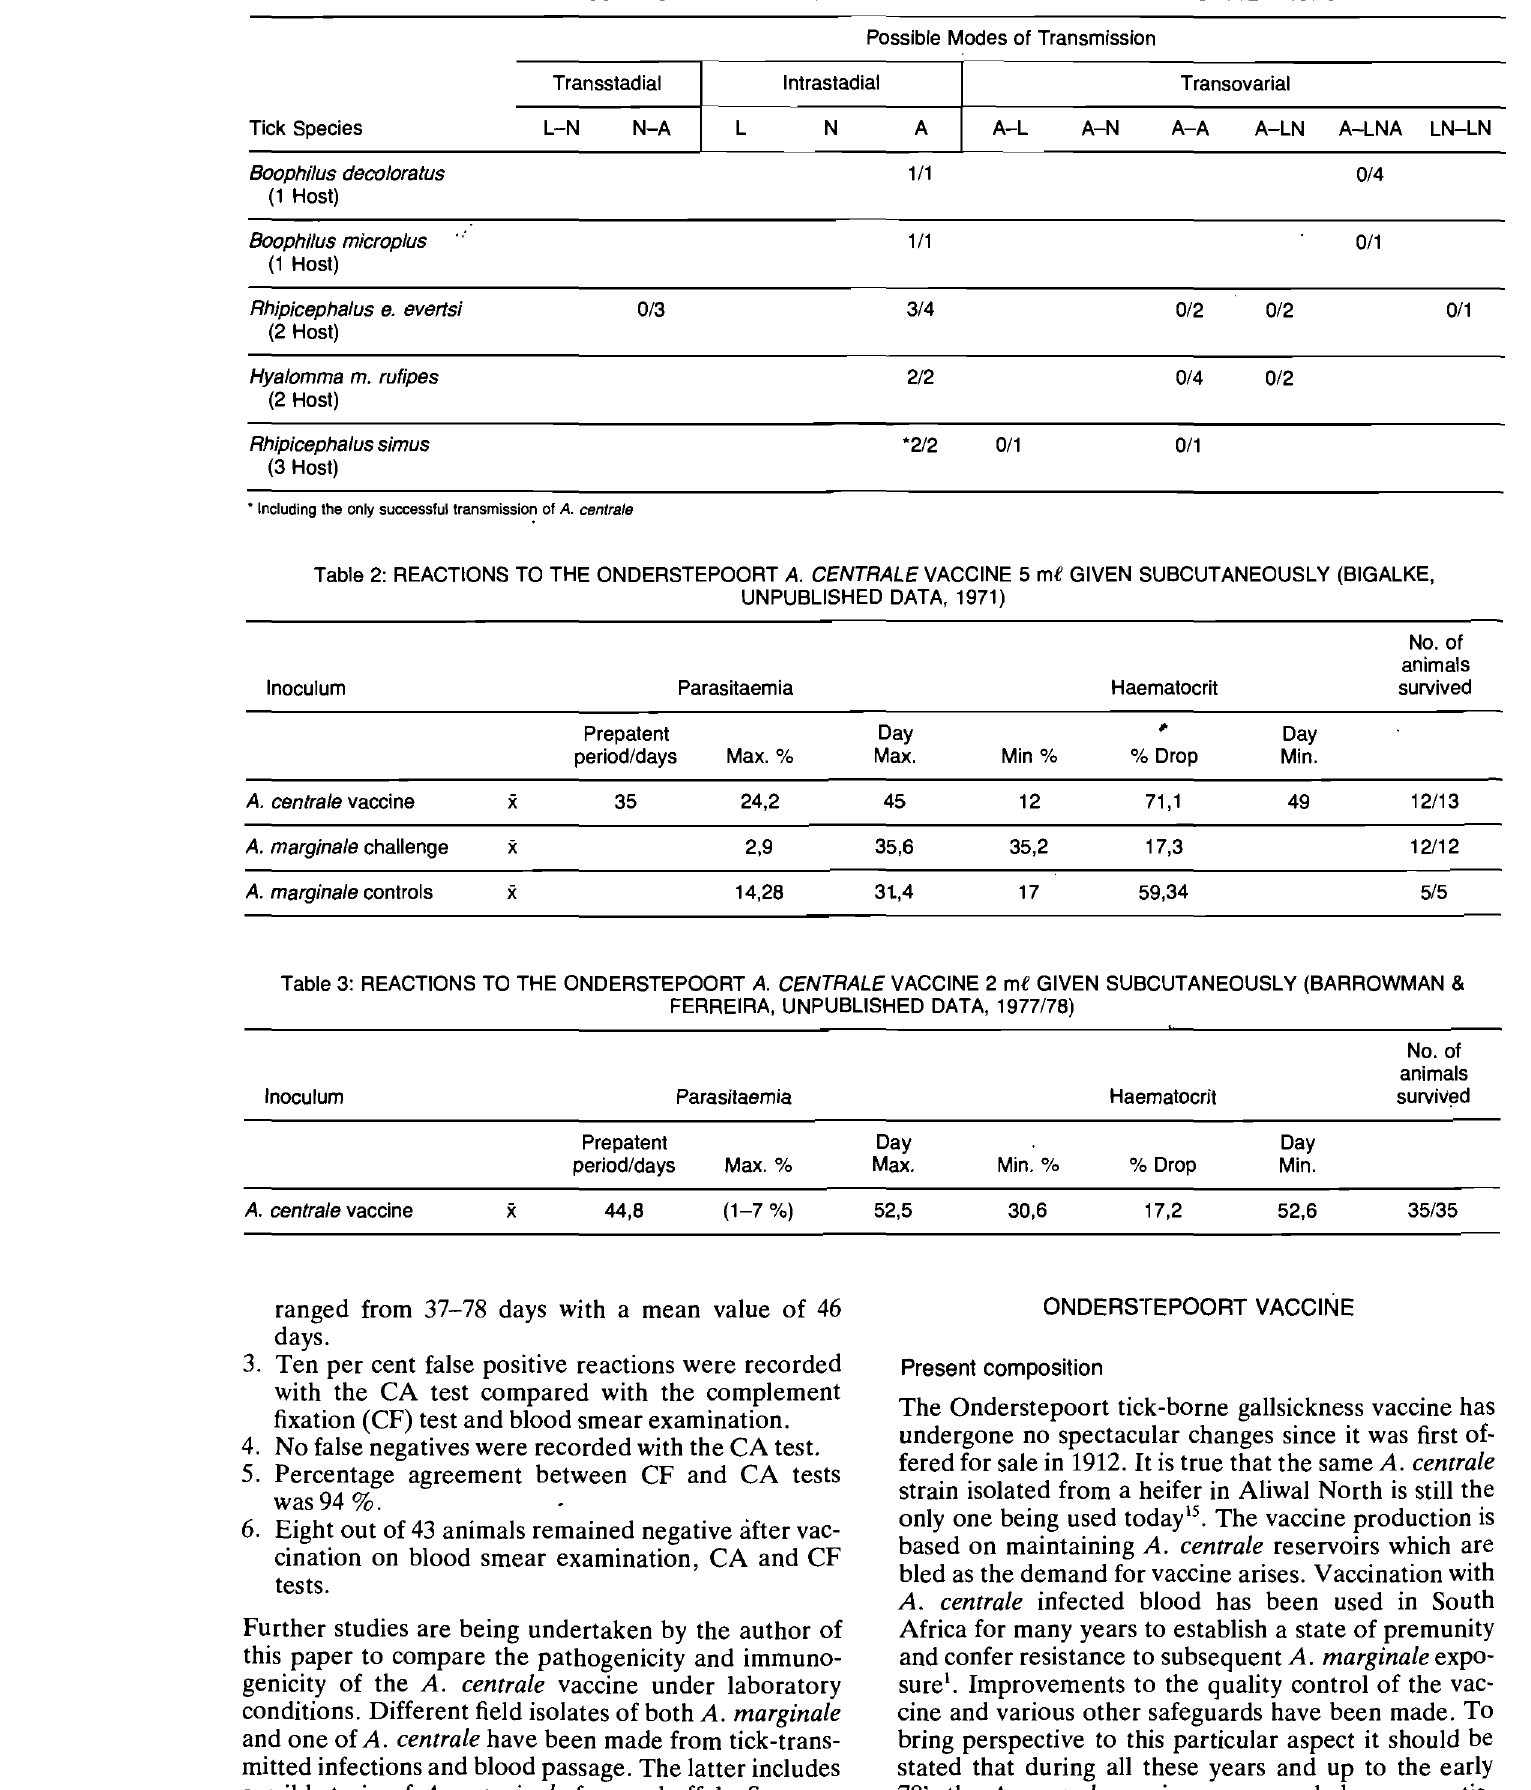
Table 2: REACTIONS TO THE ONDERSTEPOORT A. CENTRALE VACCINE 5 me GIVEN SUBCUTANEOUSLY (BIGALKE, UNPUBLISHED DATA, 1971)